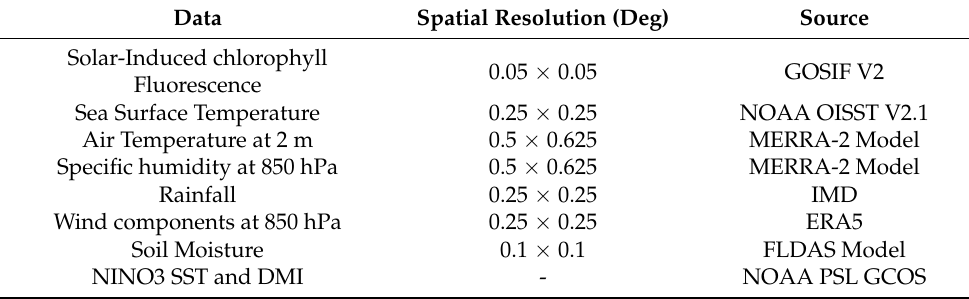
Table 1. Details of data used from 2001–2018 at monthly temporal